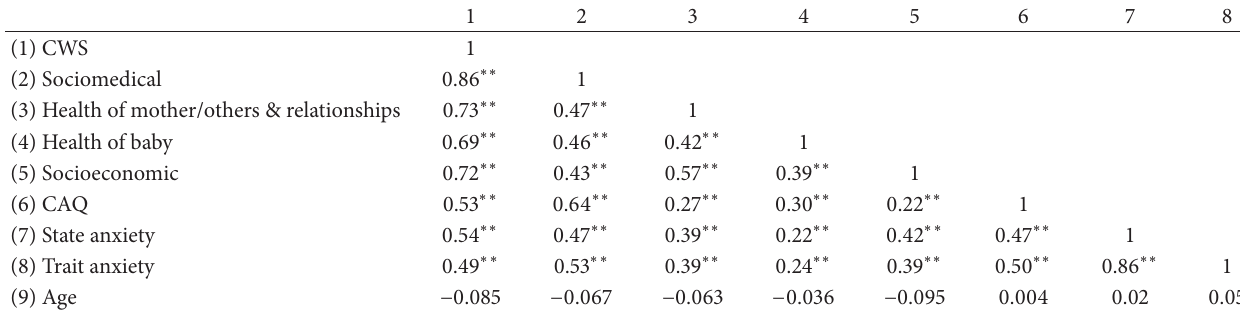
Table 4: Correlation matrix of the subscales of the 22-item Farsi CWS † , CAQ ‡ , and STAI §